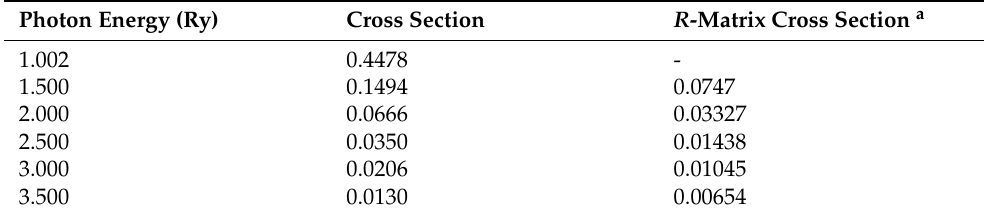
) of a hydrogen atom. 0